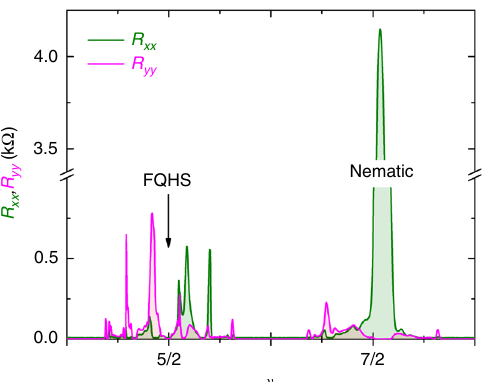
Fig. 6 Magnetoresistance in the second Landau level of sample B in the ambient. Traces are measured at ambient pressure and at T ≈ 4.5 mK. The strong resistance anisotropy at ν = 7/2 shows a nematic ground state, while at ν = 5/2 we observe a FQHS. The nature of the ground state at these two fi lling factors is marked by text